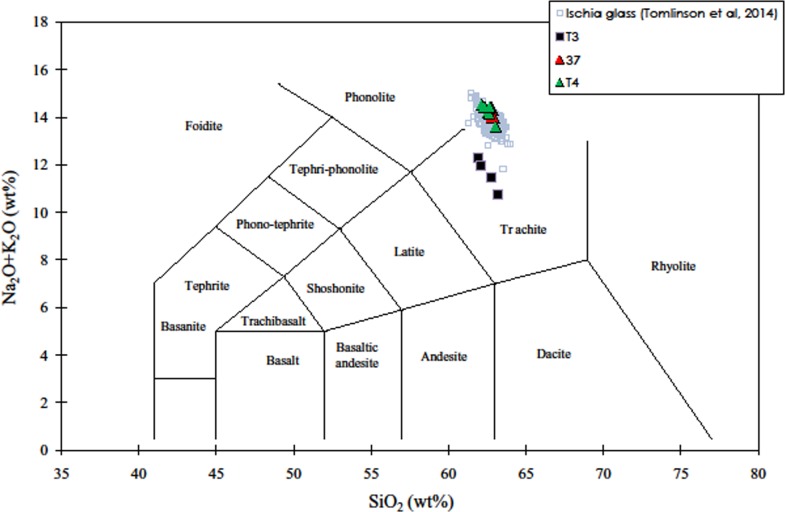
Total alkali (Na2O + K2O) vs silica (SiO2) diagram [(TAS), 67] illustrating the composition of glasses in the Moscerini cave pumice, recalculated on an anhydrous basis. Data of glasses in the Ischia pumice are reported for comparison.